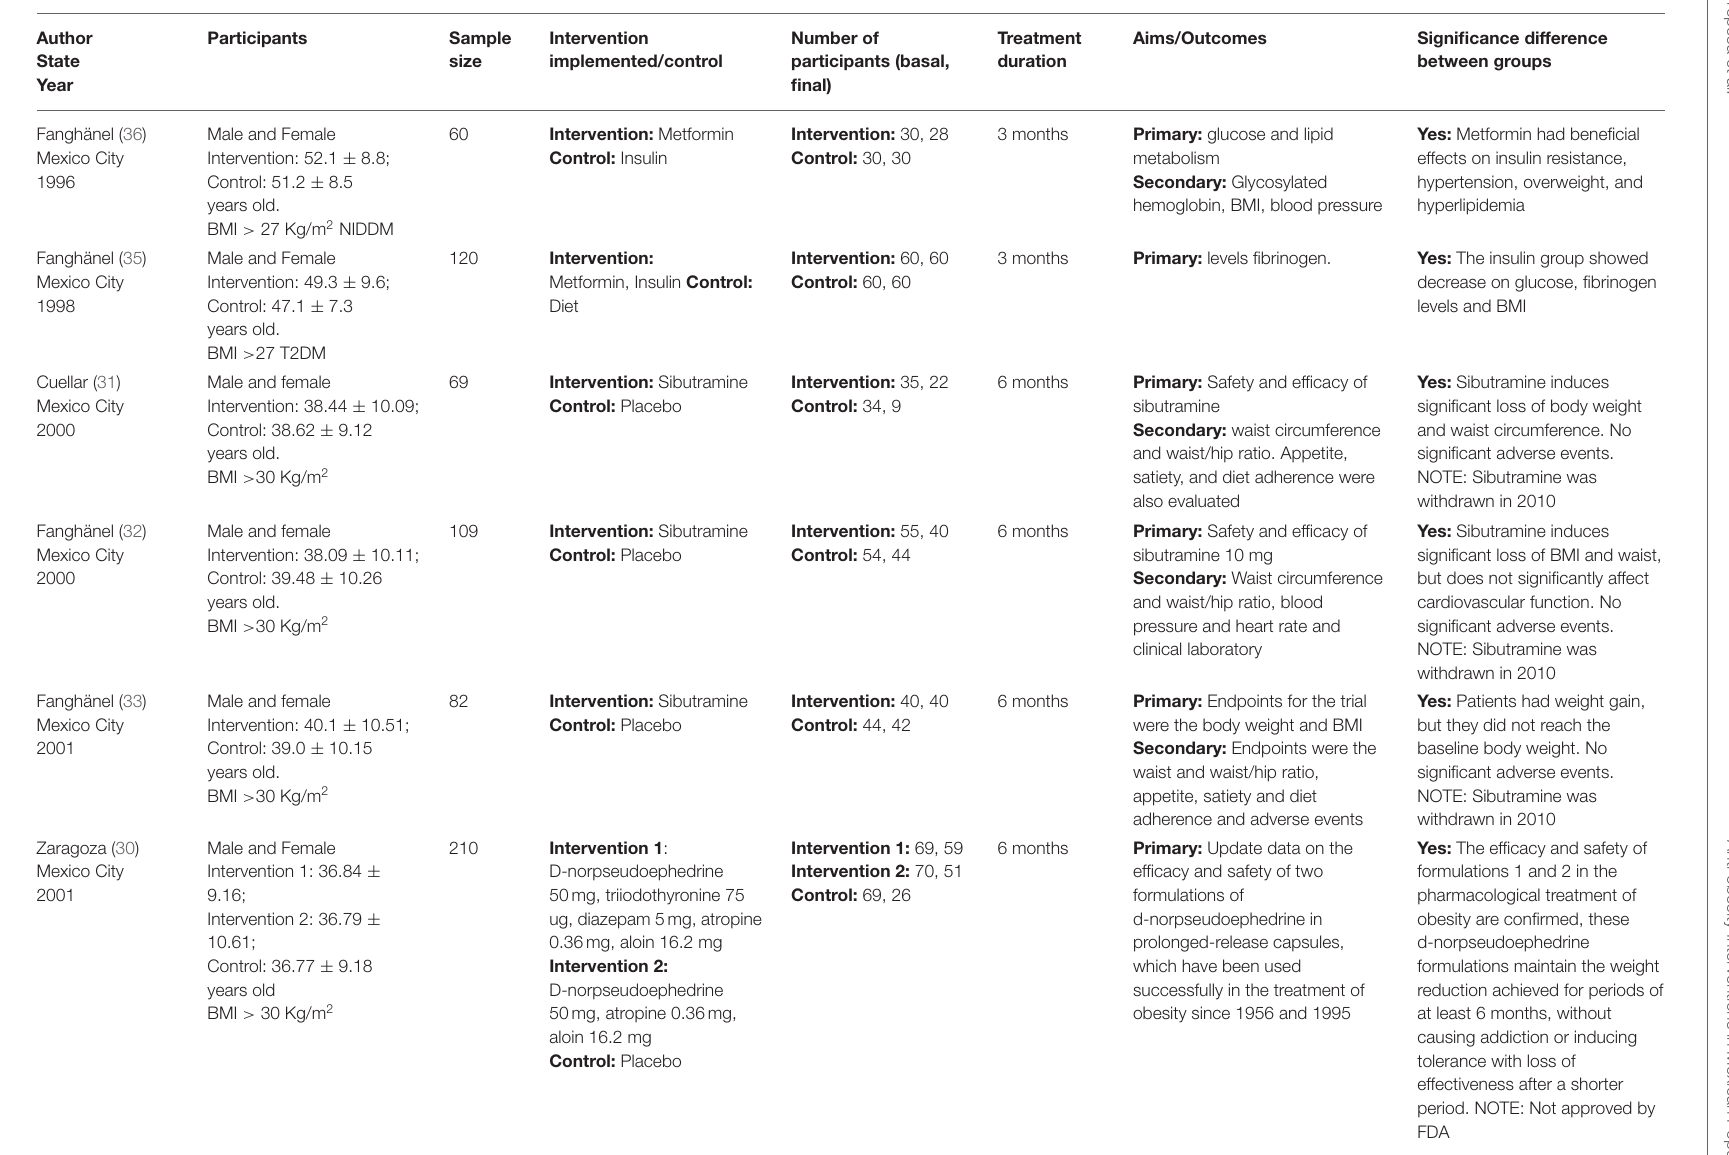
TABLE 3 | Descriptive characteristics and assessment of